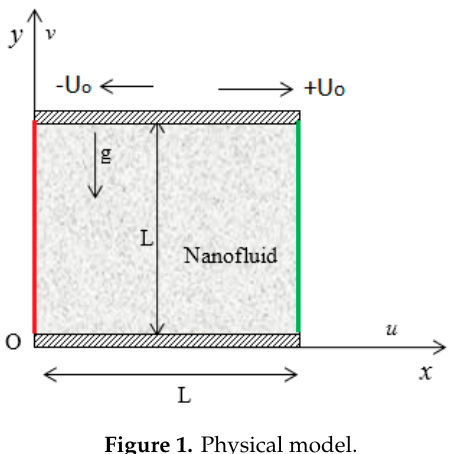
Figure 1. Physical Figure 1. Physical model.